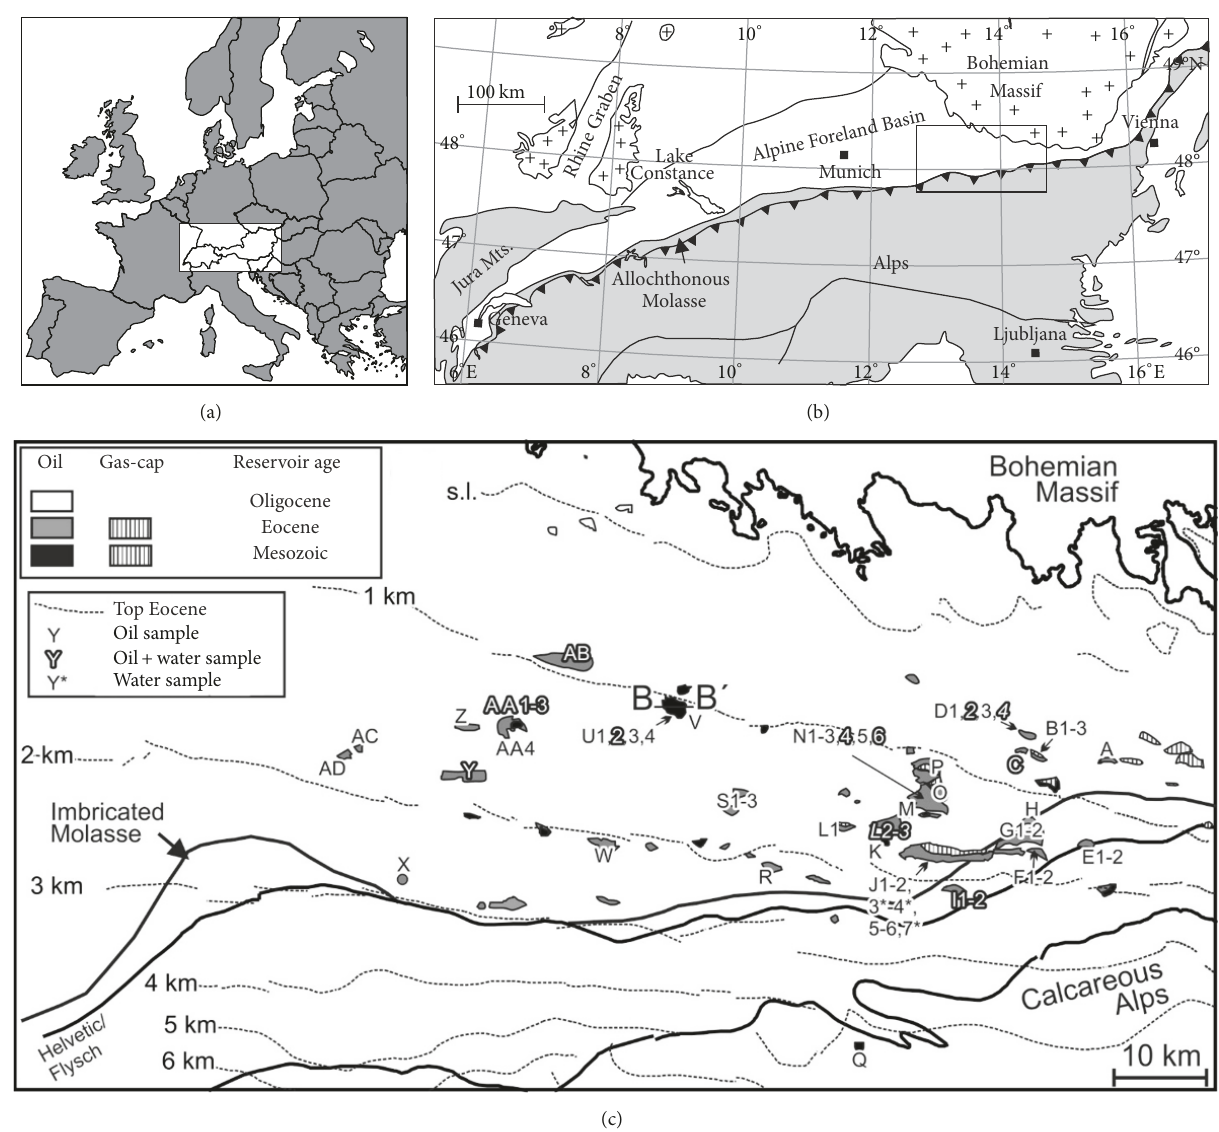
Figure 1: ((a) and (b)) Map of Europe with location of the study area in the Alpine Foreland Basin. (c) Distribution of oil fields together with the location of investigated samples. The B-B 󸀠 cross section is presented in Figure